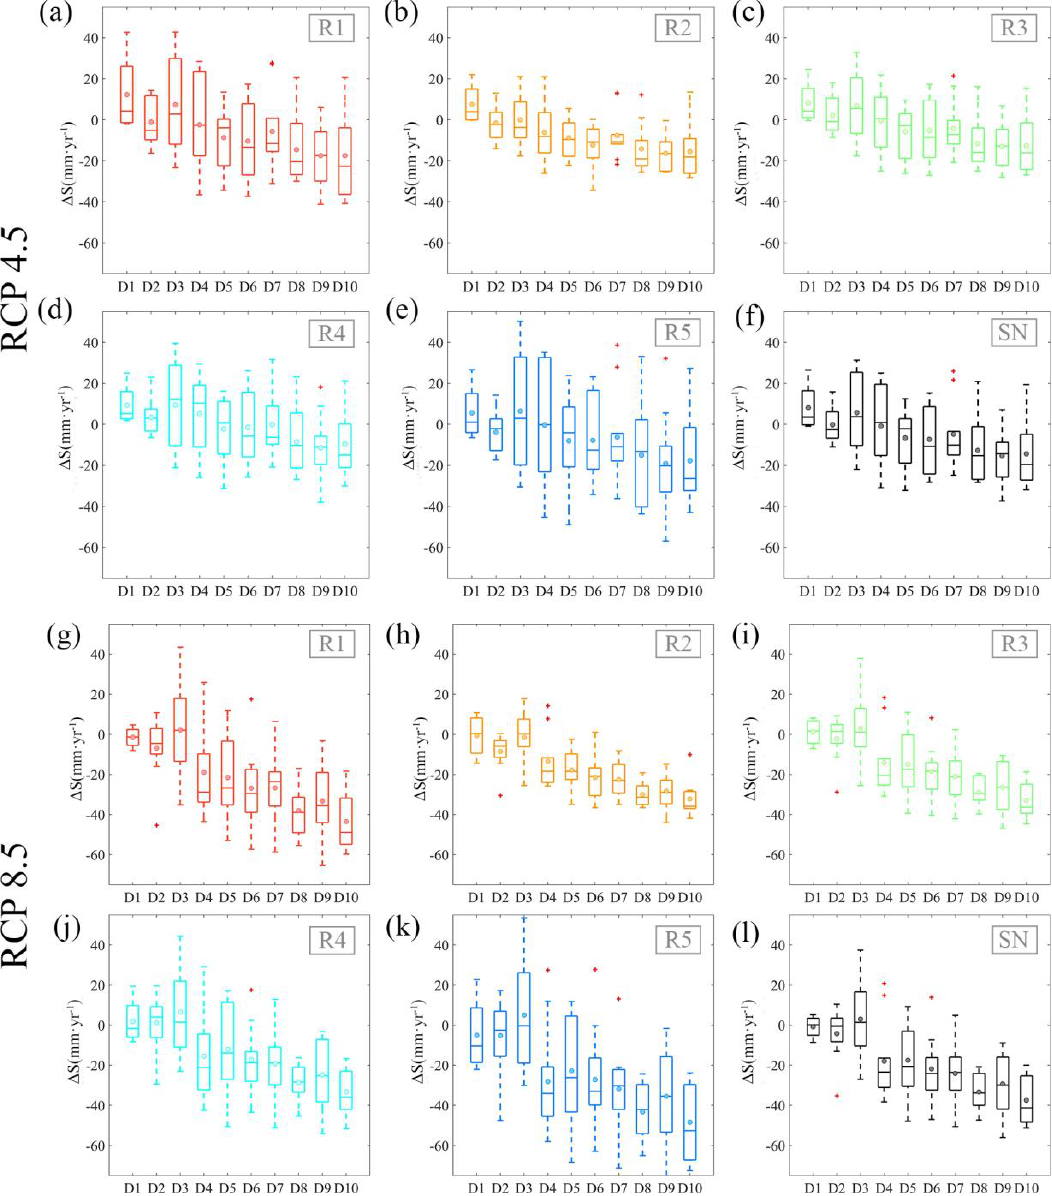
Figure 8. Decadal evolution of the mean annual snowfall anomalies during the study period in Sierra Nevada for RCP 4.5: ( a ) Region 1, ( b ) Region 2, ( c ) Region 3, ( d ) Region 4, ( e ) Region 5, and ( f ) the total study area, and the decadal evolution for RCP 8.5: ( g ) Region 1, ( h ) Region 2, ( i ) Region 3, ( j ) Region 4, ( k ) Region 5, and ( l ) the total study area.